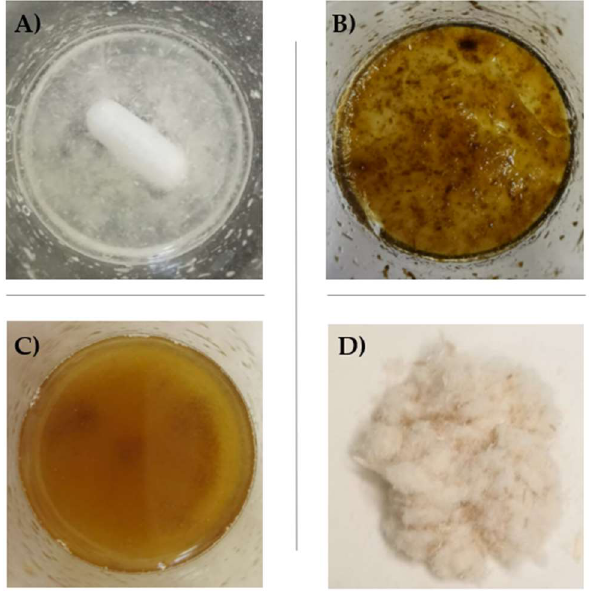
Figure 2. Different steps performed in HC functionalization with citric acid: ( A ) HC + water under stirring; ( B ) HC after 15 h at 130 °C; ( C ) HC after washing; ( D ) dried HC-CA obtained sample.